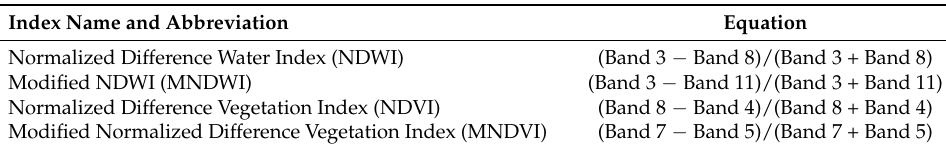
Table 3. Details on the derived